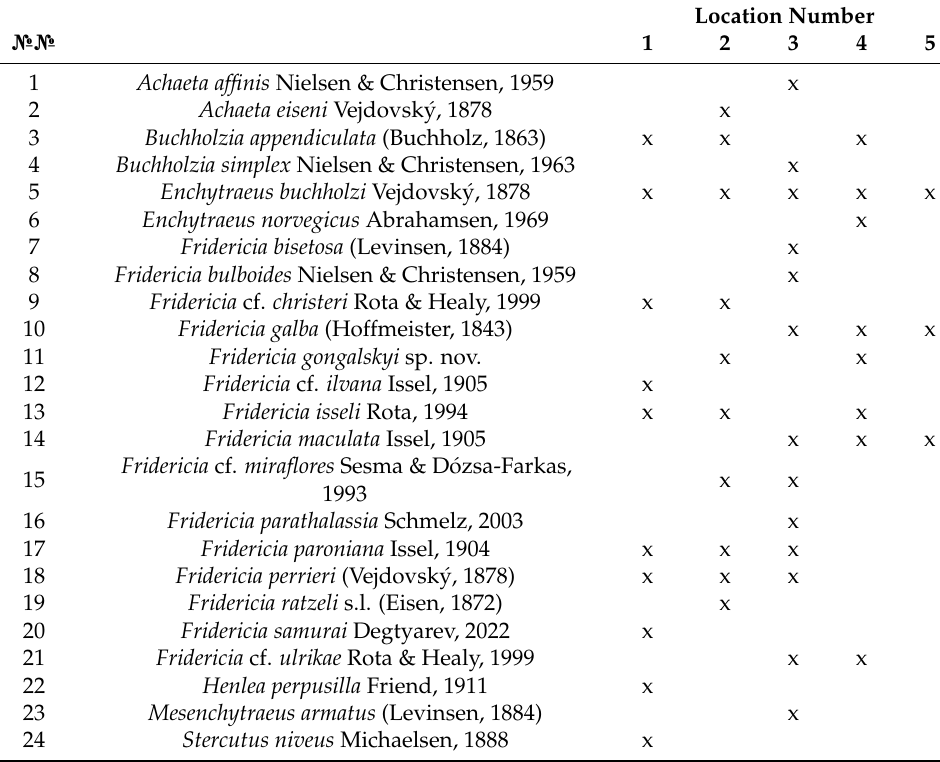
Table 3. Species of Enchytraeidae found at different sites in north-western Caucasus, Russia. The new species described in the present paper is highlighted in bold. Location numbers correspond to those in Table